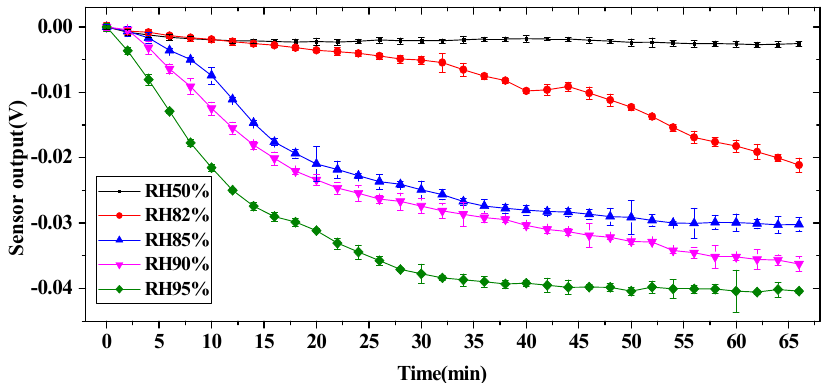
Figure 4. Sensor drift under different humidity environmen ts.